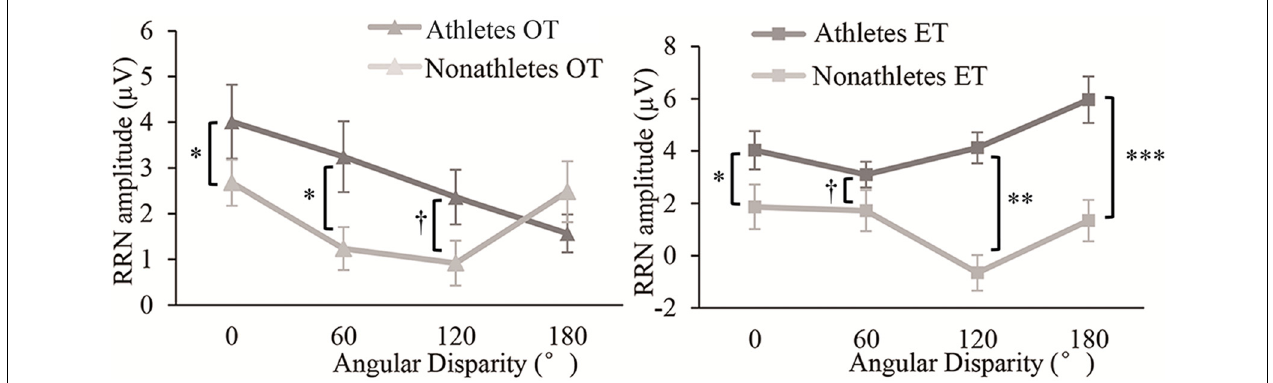
FIGURE 6 | Average amplitude of RRN at Pz per group in OT and ET condition (M ± SE). † p < 0.1, ∗ p < 0.05, ∗∗ p < 0.01, ∗∗∗ p < 0.001.